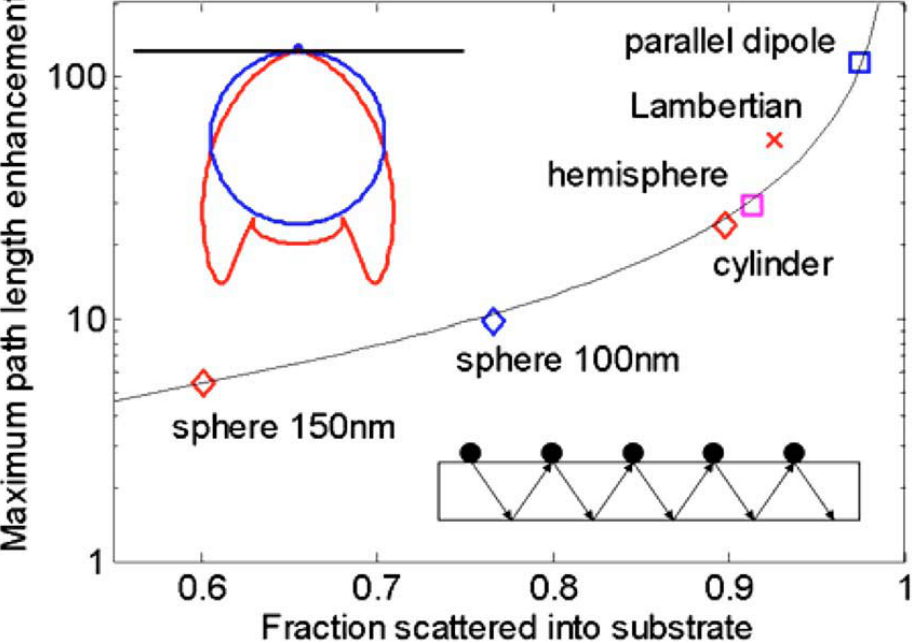
Figure 11. Maximum path length enhancement for the same geometries in Figure 10 at a wavelength of 800 nm. Absorption within the particles is neglected for these calculations, and an ideal rear reflector is assumed. The line is a guide for the eyes. Insets: (top-left) angular distribution of scattered power for a parallel electric dipole that is 10 nm above a Si surface and Lambertian scatterer; (bottom-right) geometry considered for calculating the path length enhancement (reprinted with permission from [47]. © 2008, American Institute of